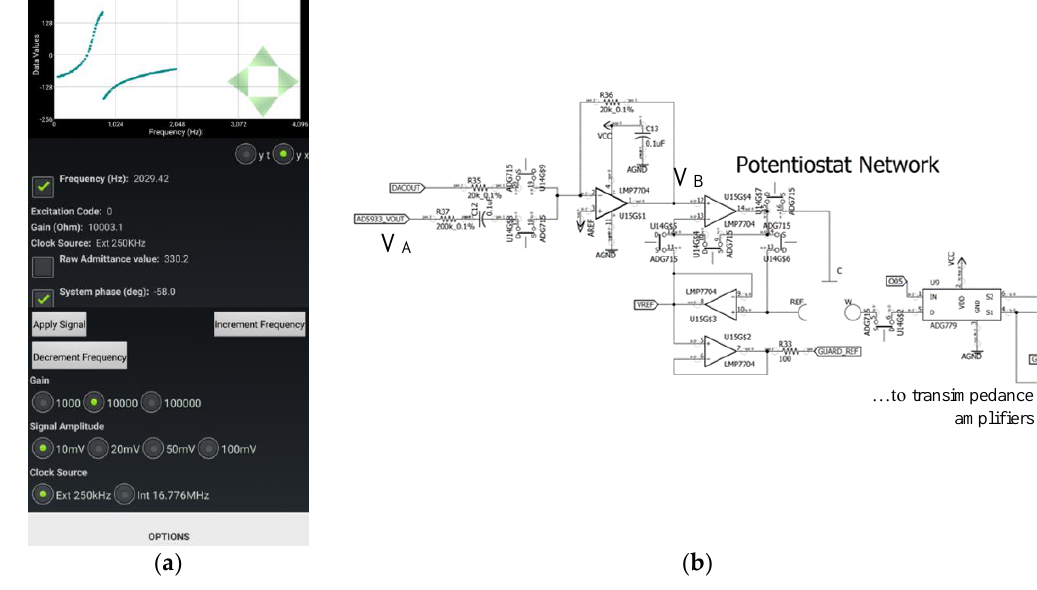
Figure 4. ( a ) Implementation of ABE-VIEW to set the frequency and amplitude of ( b ) the control signal to custom potentiostat network. The control voltage (V B ) into the potentiostat network is composed of a weighted sum and inversion of the voltage from a digital synthesizer (V A ) of a network analyzer chip (Analog Devices AD5933) with AC coupling, and a low pass filtered digital to analog converter voltage to apply arbitrary DC bias. This enables the device to perform any basic potentiometric or amperometric method in 2 or 3 electrode configuration, as well as electrochemical impedance analysis with arbitrary bias.